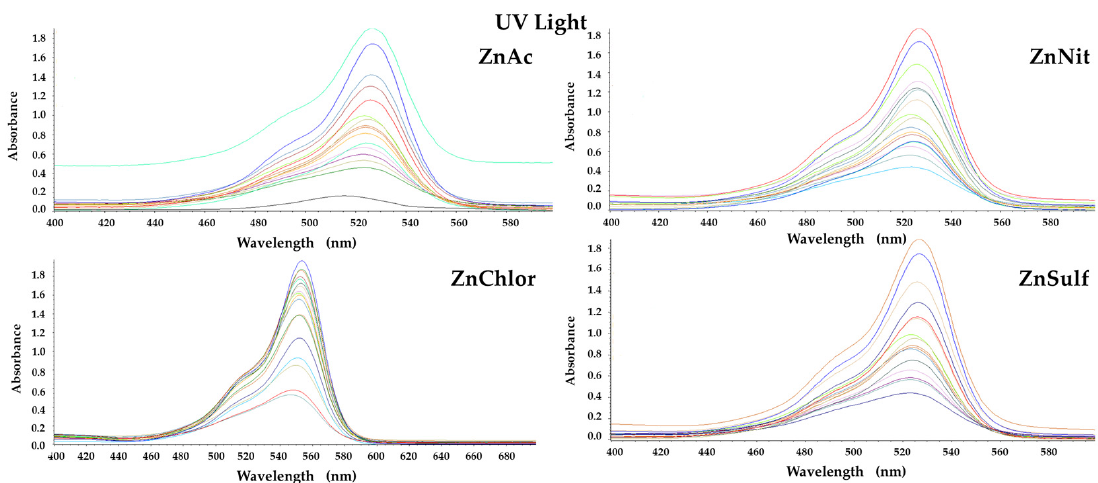
Figure 9. Real time UV–Visible spectra under visible light photocatalytic degradation of Rhodamine B, by the four ZnO powders, produced by different precursors.